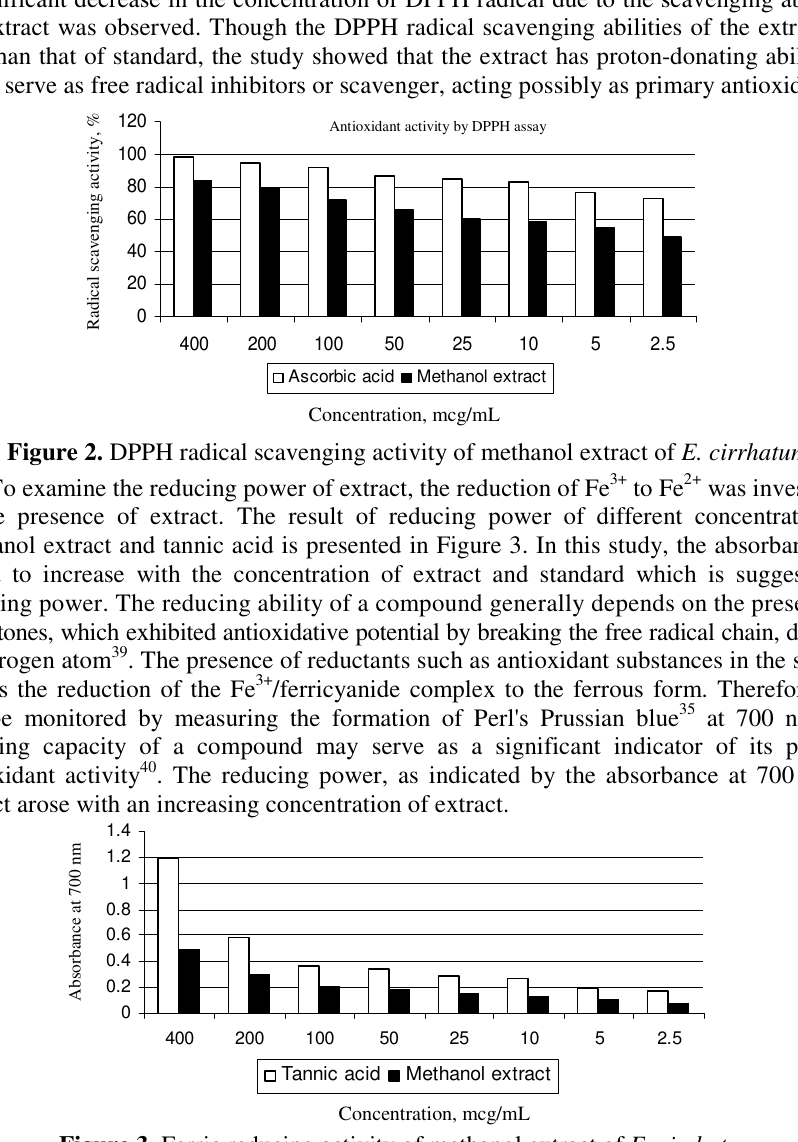
Figure 3. Ferric reducing activity of methanol extract of E.